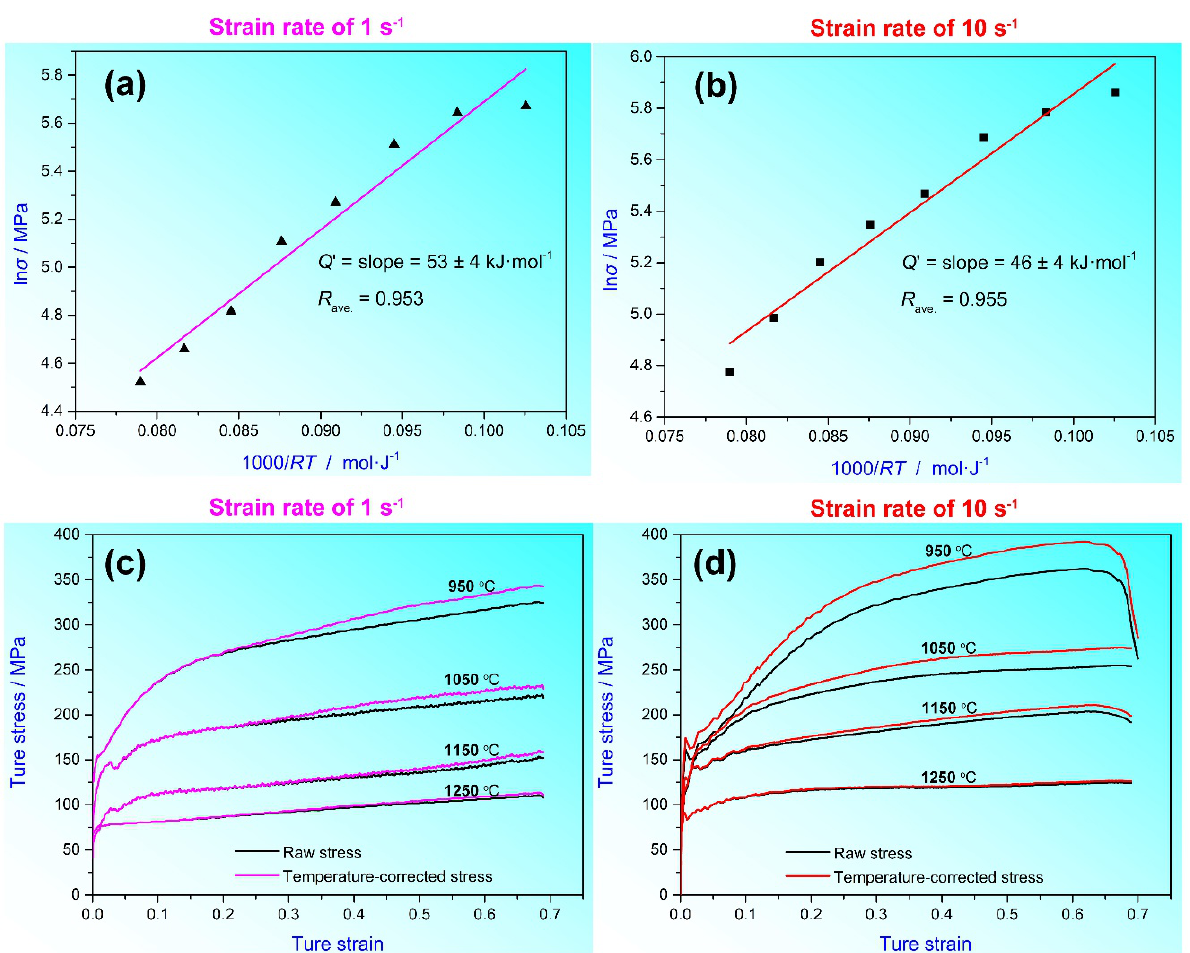
Figure 3. The dependence of ln σ on 1/ T at a strain rate of 1 ( a ) and 10 s −1 ( b ). The temperature- corrected stress varying with strain at the strain rates of 1 ( c ) and 10 s −1 ( d ).